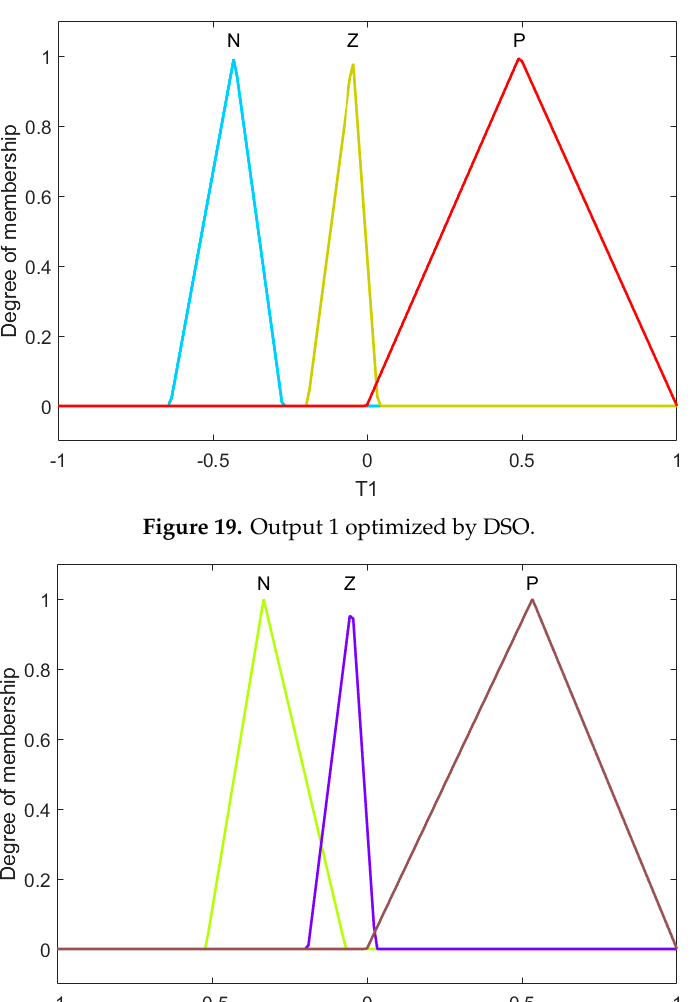
Figure 18. Input 2 optimized by DSO.